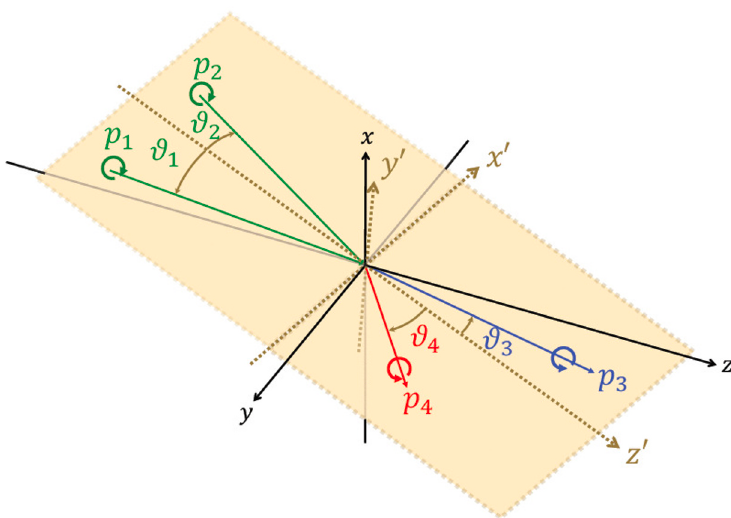
Figure 4 . Kinematical parameters in asymmetric-incident and non-coaxial geometry. Primed coordinates ( x 0 ; y 0 ; z 0 ), where the total transverse momentum of an arbitrary selected pair of incident photons within the creation beam vanishes, are con(cid:12)gurable with respect to the (cid:12)xed laboratory coordinate ( x; y; z ) to which the focused beam (cid:12)elds are physically mapped. The kinematical parameters used to derive the scattering amplitude are all based on these primed